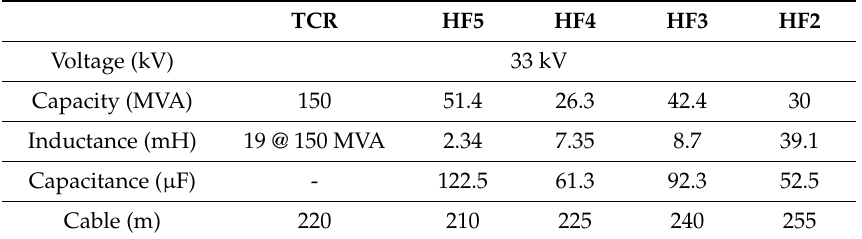
Figure 11. Electromagnetic Transients Program(EMTP)modelingfor electric arc furnace. Table 3. Parameters for thyristor-controlled reactor (TCR) and harmonic filter banks.